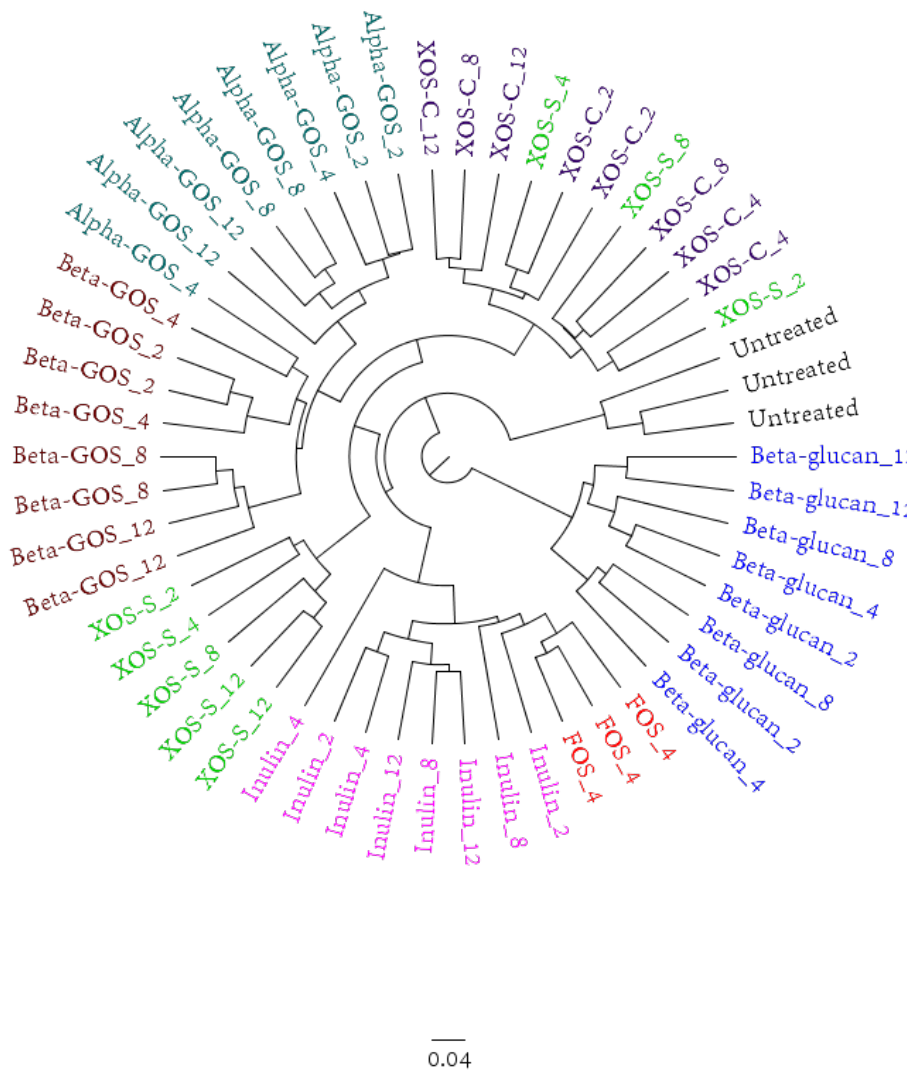
Figure 2. Clustering tree based on the Bray-Curtis dissimilarity of microbiota composition data, assessed by 16S rRNA gene amplicon sequencing. The number after the fiber indicates the concentration (in mg/mL) at which the fiber was added to the fermentation medium. The fiber concentration of 0.5 mg/mL is not depicted.